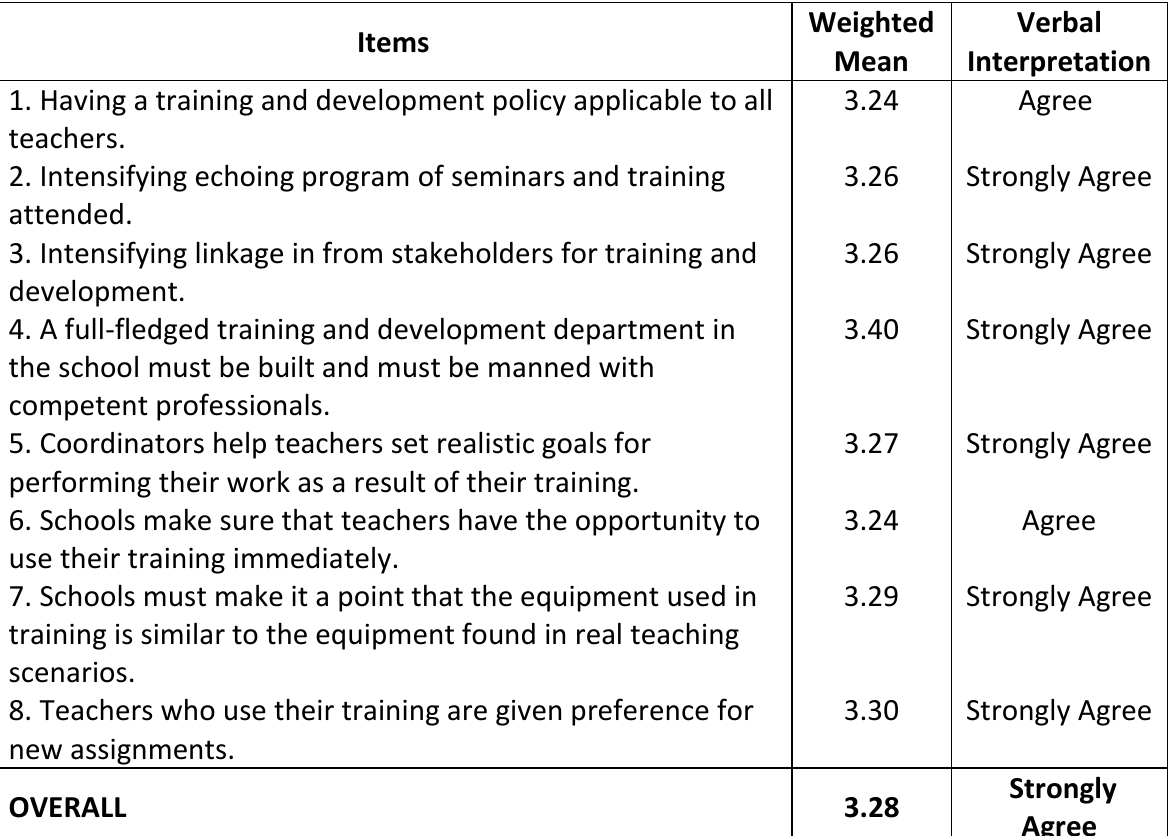
Table 12 : Weighted Means of the Factors Affecting Students’ Progress as to Support to Teacher